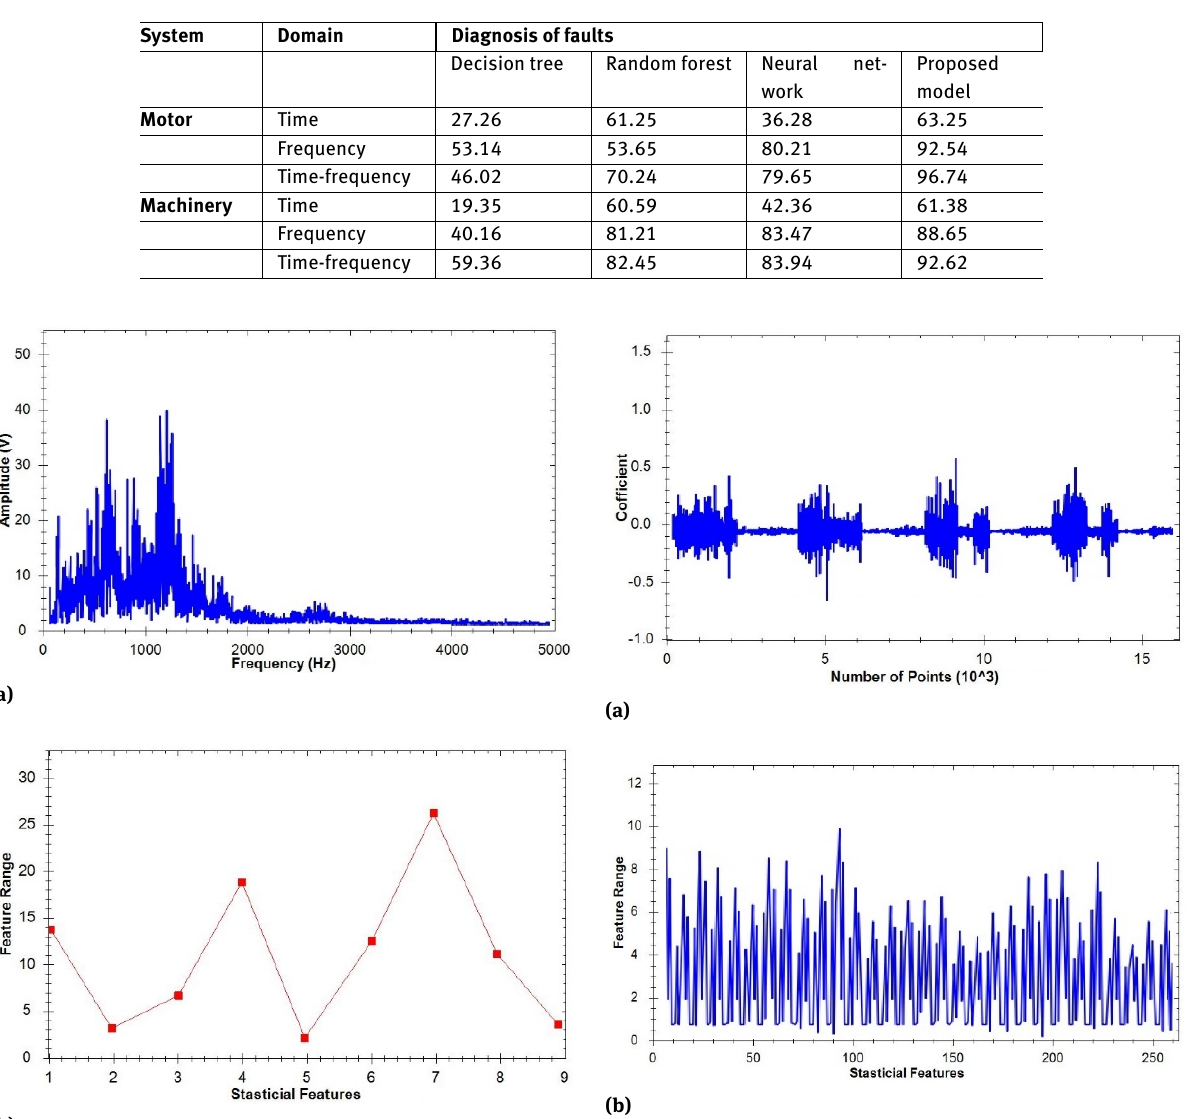
Table 2: Classification rate of faults of dataset in various domains